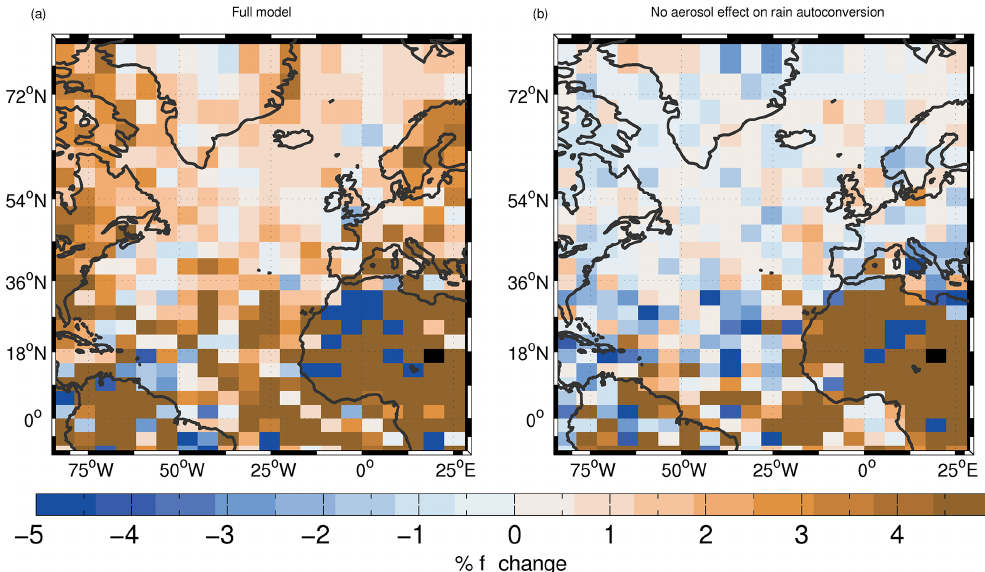
Figure E2. As for Fig. E1 except for f c